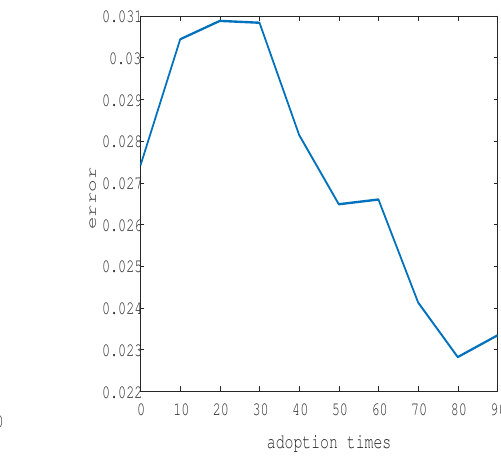
( b ) Sampling error curve.